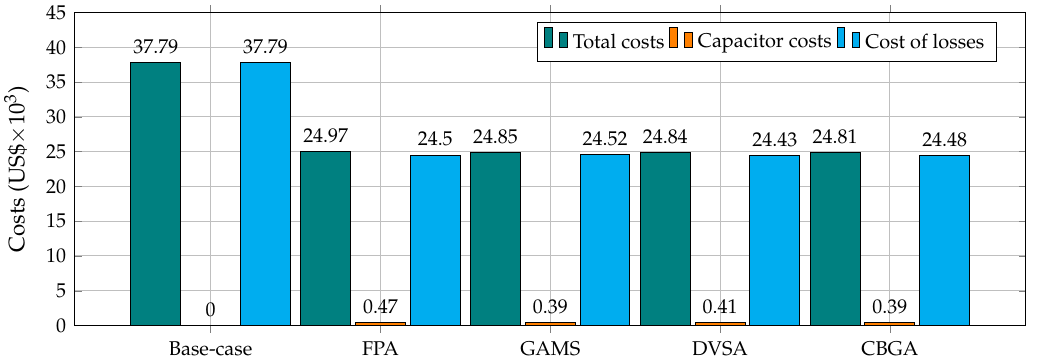
Figure 13. Discriminated costs for the 69-node test